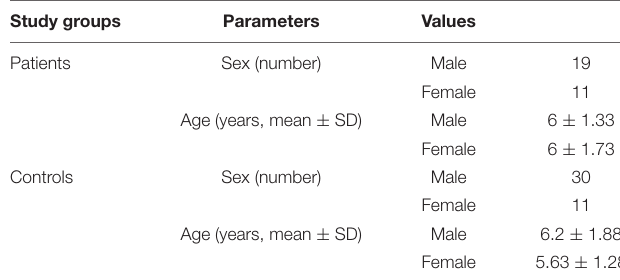
TABLE 2 | General demographic data of enrolled cases and